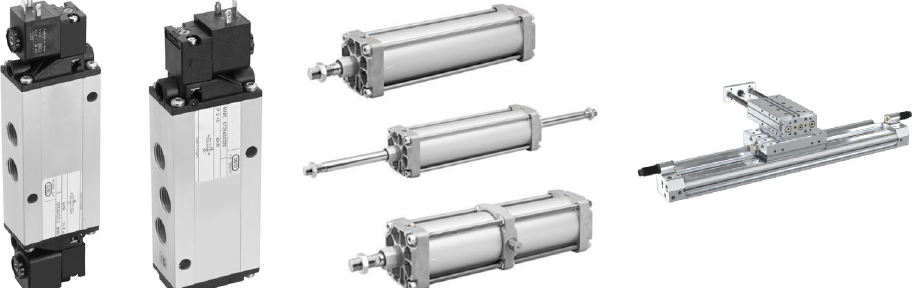
Figure 1. Some representatives of part families produced in the factory.